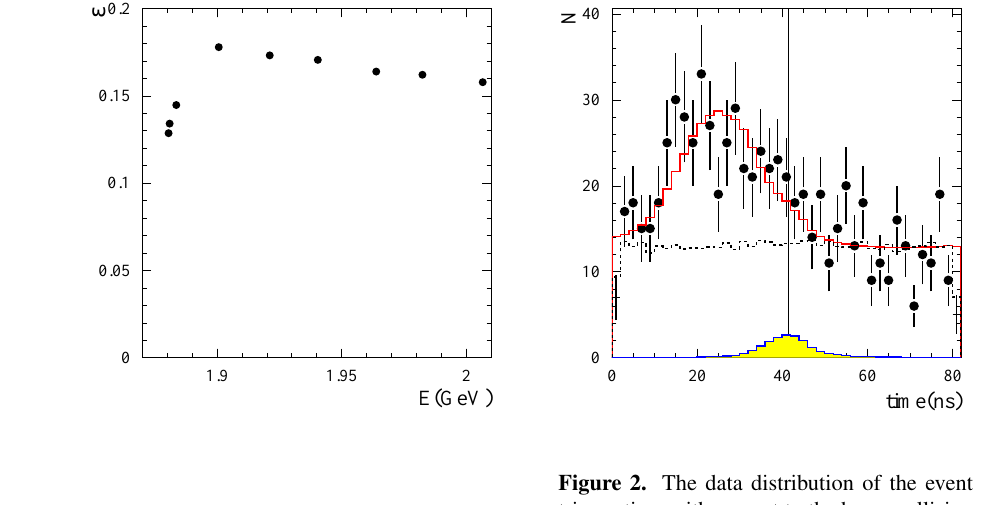
Figure 2. The data distribution of the event trigger time with respect to the beam collision time (point with error bars). The dashed his- togram represents cosmic background. The filled histogram shows the expected beam background distribution. The solid histogram is the result of the fit described in the text. The vertical line indicates the position of zero de- lay between the trigger and the beam